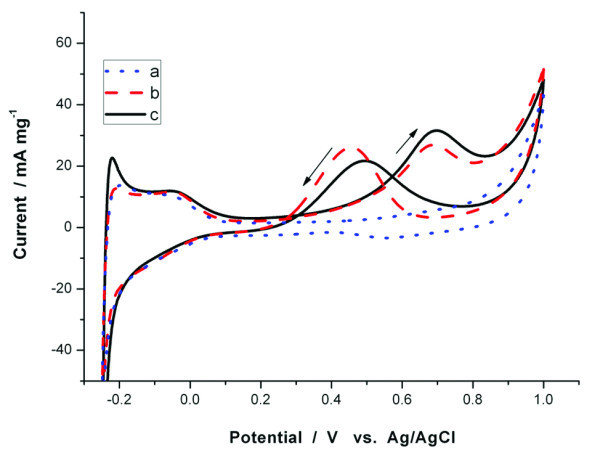
Cyclic voltammetric curves for the electrooxidation of methanol (sweep rate: 50 mV s-1, 0.5 mol L-1 H2SO4, 2 mol L-1 CH3OH, 298 K). (a) the first cycle of Au@Pt0.57Ag0.43 NRs; (b) the 25th cycle of Au@Pt0.57Ag0.43 NRs; (c) the first cycle of graphene/Au@Pt0.57Ag0.43 NRs.